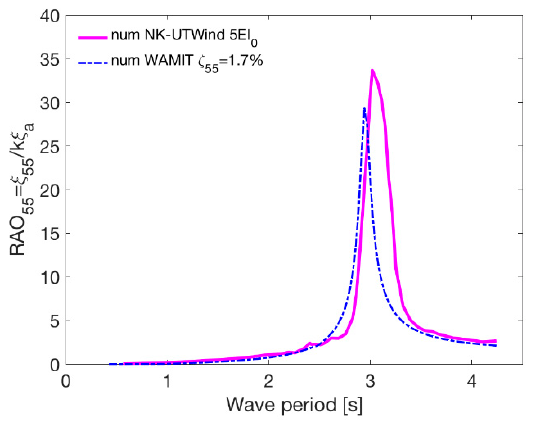
Figure 23. RAO pitch motion result comparisons between the NK-UTWind and WAMIT numeri- cal calculations.